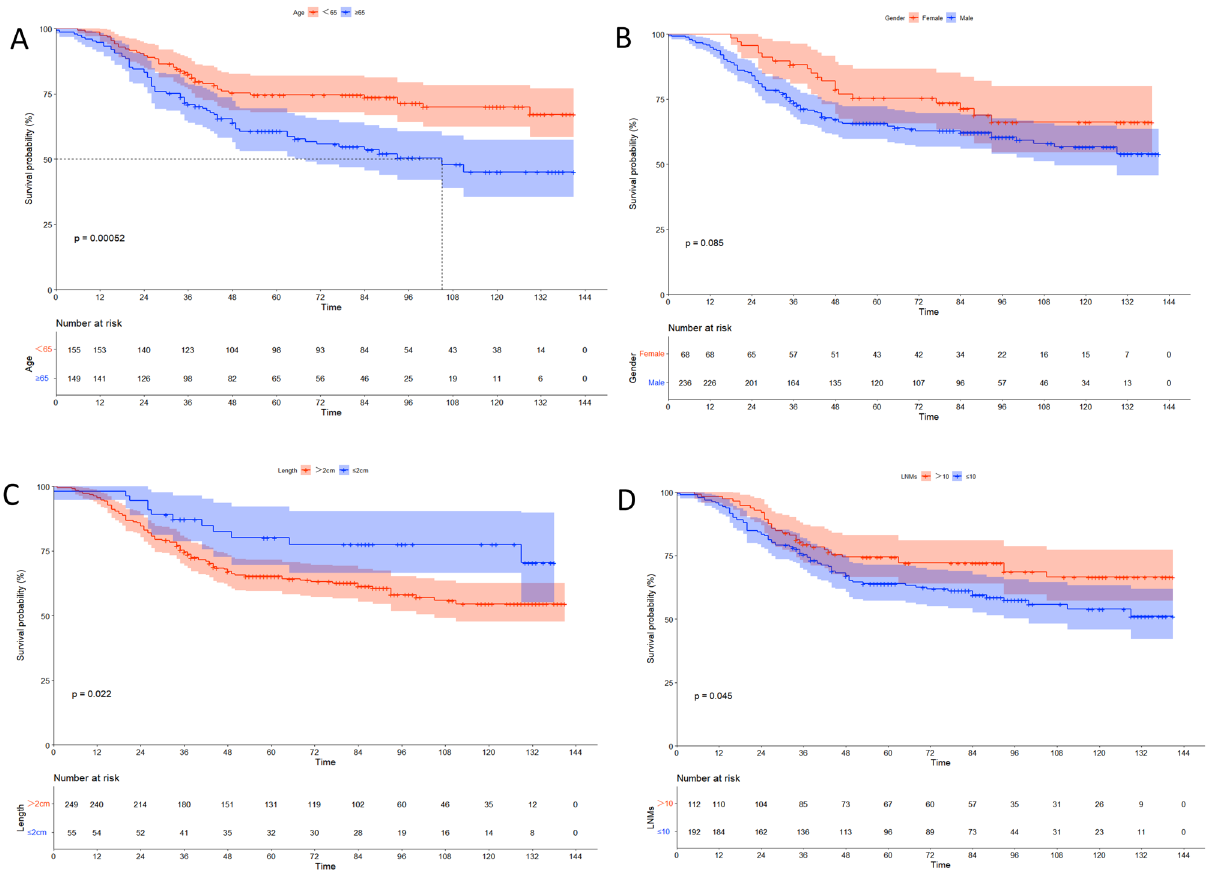
Figure 1. Kaplan–Meier curves for the OS of the training cohort. Age group ( A ), sex group ( B ), length group ( C ), lymph node metastasis (LNM) group ( D